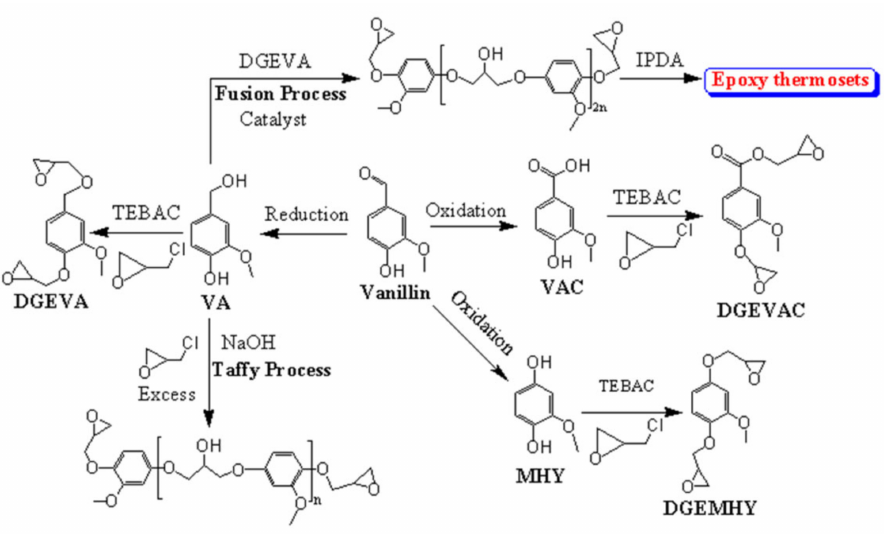
Figure 6. An illustration schematic reaction of epoxy monomers and epoxy thermosets